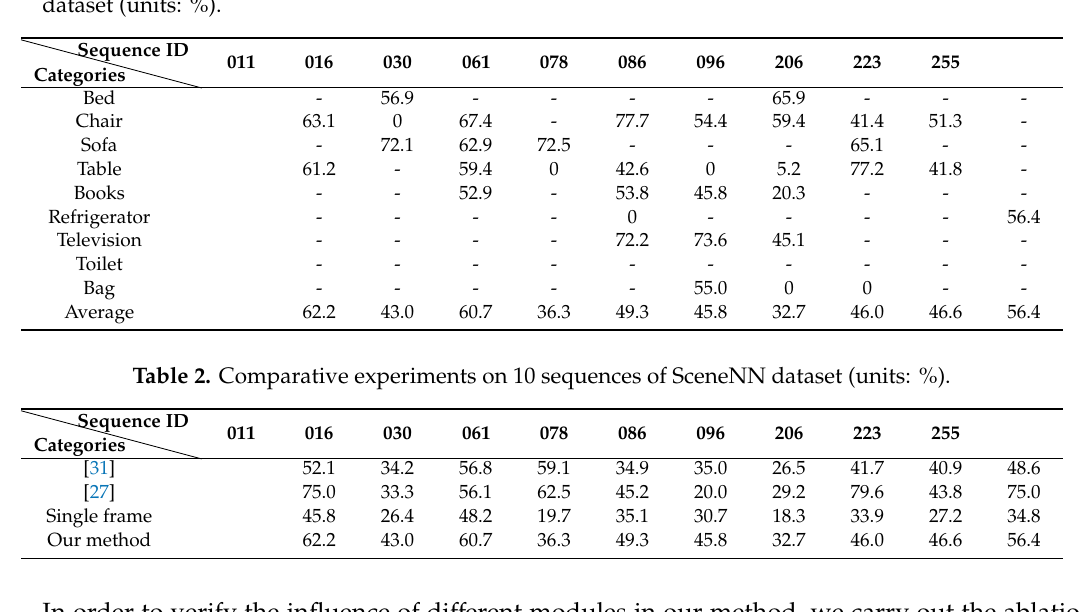
Table 1. 3D object semantic segmentation experiments of our method on 10 sequences of SceneNN dataset (units: %).